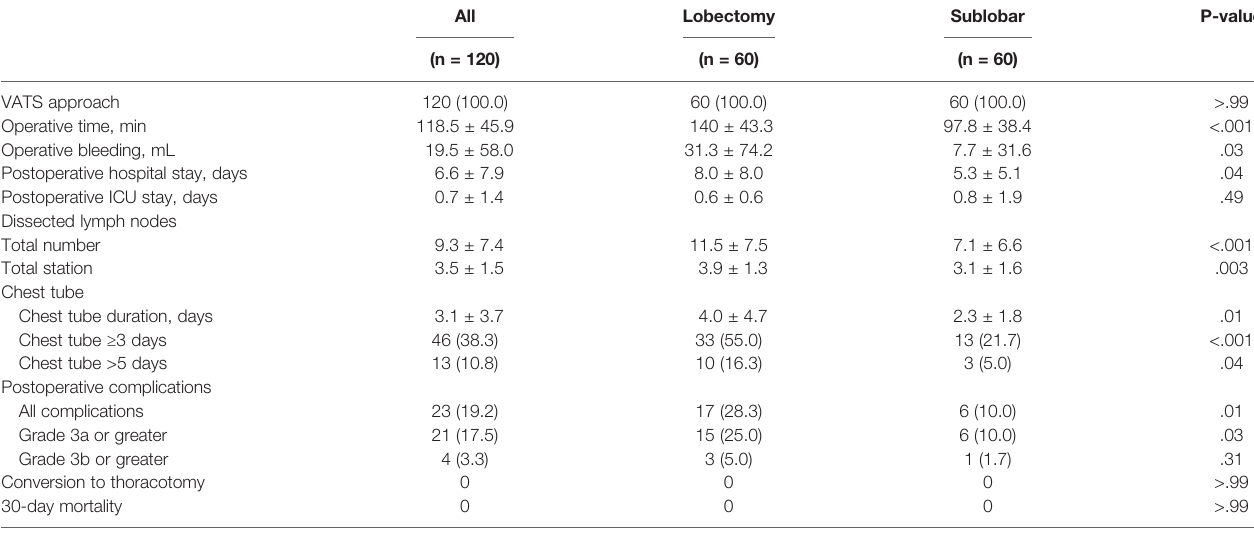
TABLE 3 | Perioperative outcomes after propensity score matching.